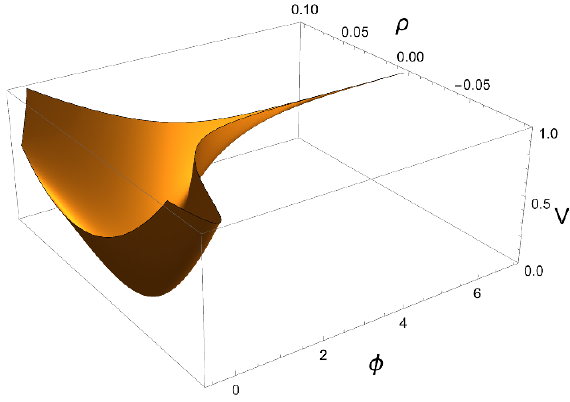
Figure 1 . The scalar potential for (cid:30) and (cid:26) with V 0 = M 2 (1 (cid:0) (cid:28) ) 2